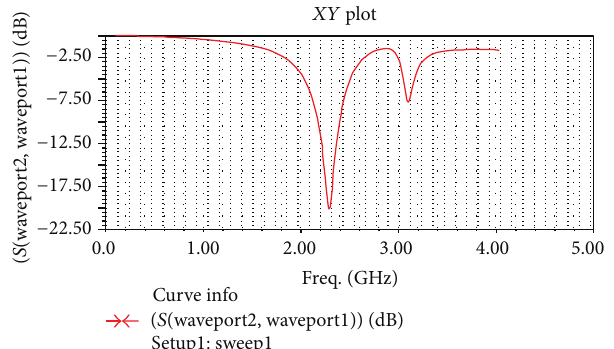
Figure 3: Variation of the coefficient of transmission S21 versus frequency at 40 ∘